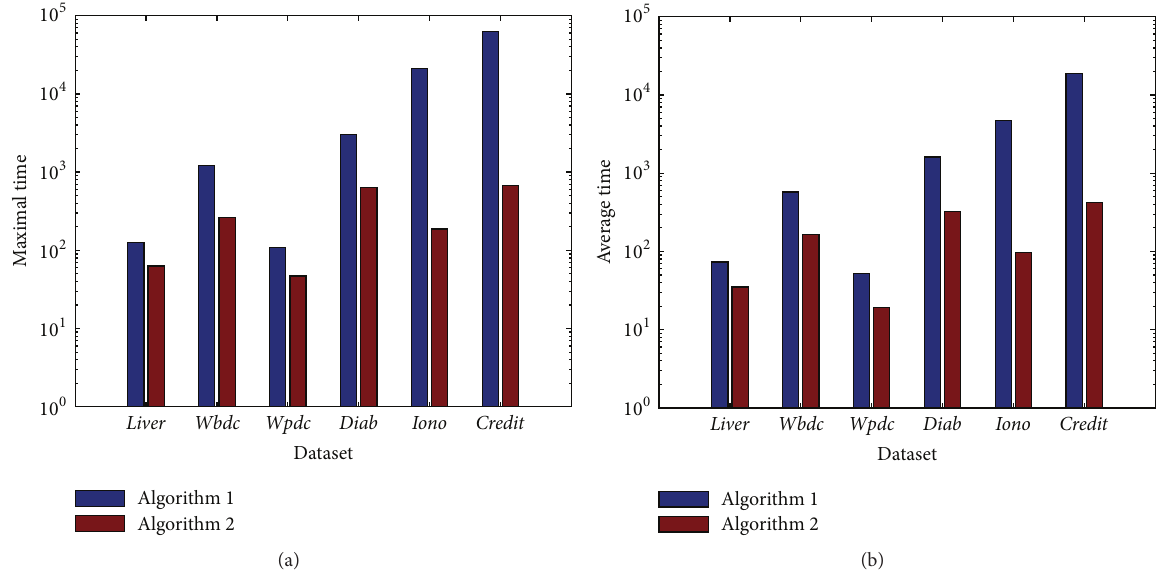
Figure 1: Run time comparison: (a) maximal time and (b) average time.